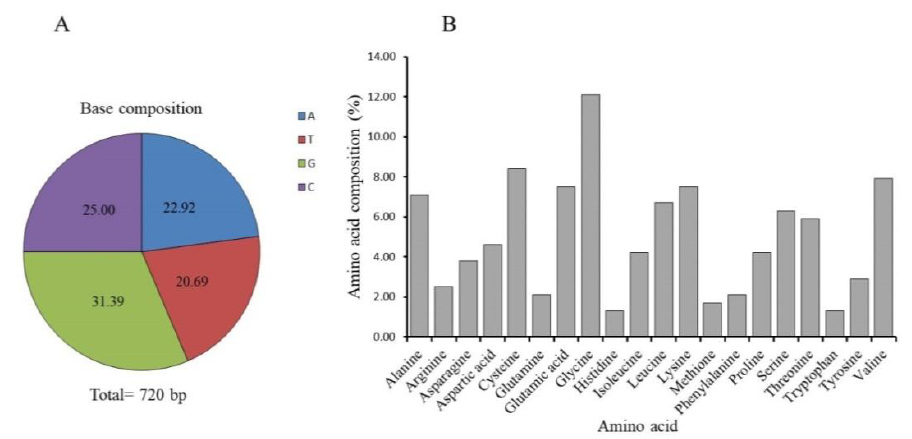
Figure 2. Sequence compositions of Hdh IGFBP7 CDs region at the nucleotide and amino acid levels. ( A ) Base composition, ( B ) Amino acid composition.